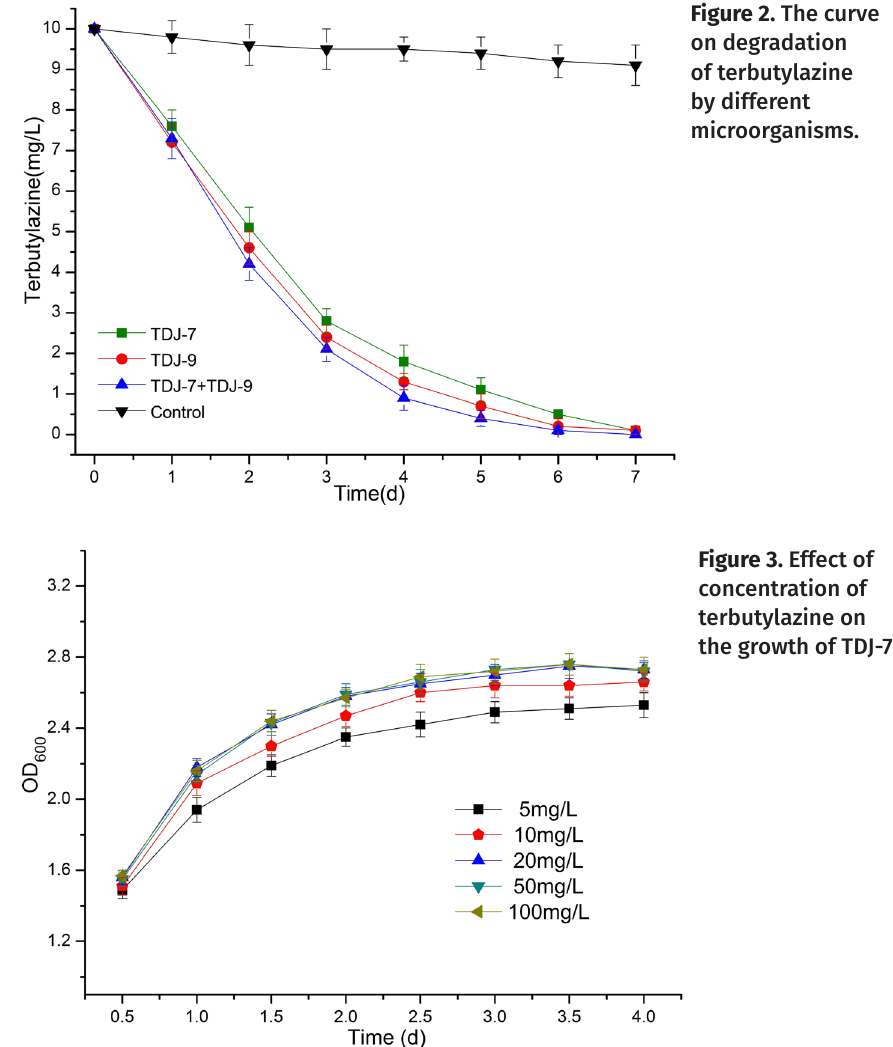
Figure 3. Effect of concentration of terbutylazine on the growth of TDJ-7.